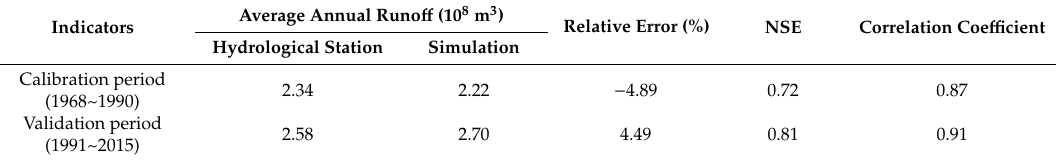
Figure 6. Schematic diagram of the effect of subsoiling on the soil plough layer. 2.4.2. Scenario Setting Scholars have conducted many experiments on different farming methods at the farm scale, mainly for the observation of soil properties, structure, and moisture. These methods are summarized based on the following three aspects.